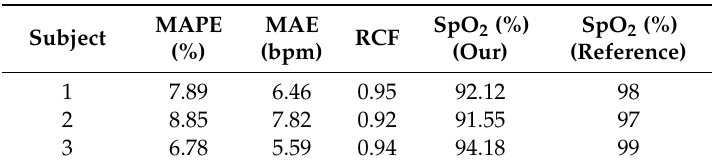
Table 4. Performance of our proposed wearable pulse oximeter device for the up-down finger motion